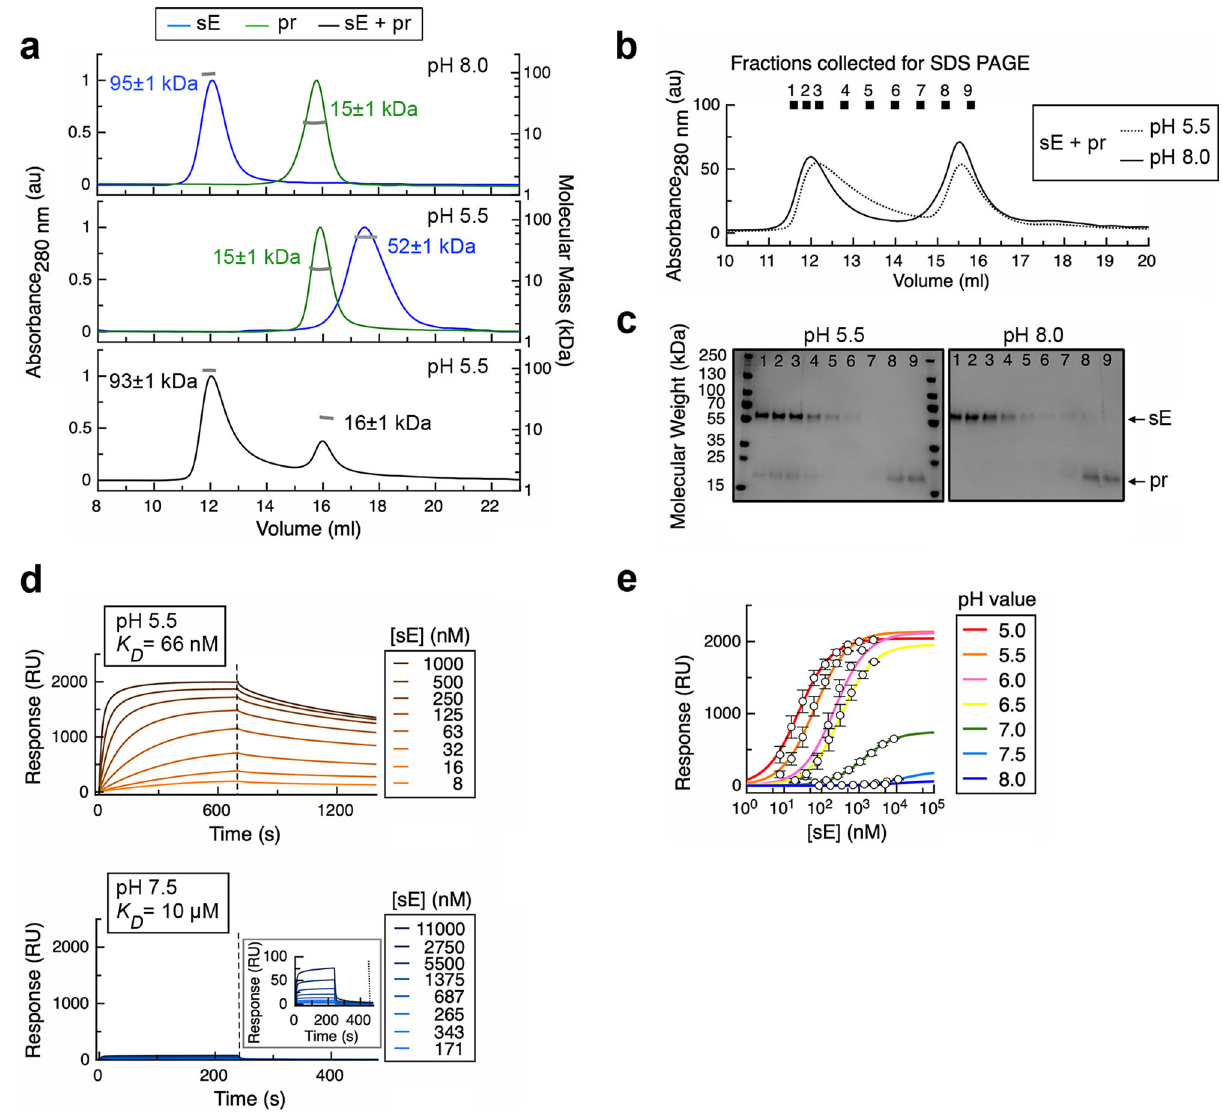
Fig. 1 pr stabilizes the sE dimer at acidic pH. a SEC elution volume pro fi les of isolated sE and isolated pr equilibrated at pH 8.0 (top panel) and at pH 5.5 (middle panel). The bottom panel shows the elution of a mixture of sE with pr in excess (1:2 sE:pr monomer:monomer molar ratio) at pH 5.5. Left y axis: the ultraviolet absorbance normalized by setting the highest peak to 1. Right y axis: molecular mass (kDa) determined by MALS, with the values for each species indicated on the corresponding peak. b Superposition of the SEC elution pro fi les of the mixture of sE with an excess pr equilibrated at pH 8.0 (smooth curve) and at pH 5.5 (dotted curve) as described in Methods. The fractions analyzed by SDS-PAGE in ( c ) are indicated (1 – 9). c SDS-PAGE of the SEC fractions indicated in ( b ) at pH 5.5 (left) and pH 8 (right); Coomassie blue staining. d Surface plasmon resonance (SPR) sensorgrams with pr immobilized on the SPR chip and sE fl owed at different concentrations (color-coded as indicated) at pH 5.5 (top panel) and pH 7.5 (bottom panel). Both panels are shown at the same vertical scale (0 – 2000 RU), with the inset in the bottom panel amplifying the range between 0 and 100 RU to show the actual curves, as the interaction at pH 7.5 is much weaker. A dashed vertical line indicates the transition from association to dissociation kinetics. e SPR association equilibrium values as a function of sE protein concentration for the titrations measured at different pH values, ranging from 5 to 8. The measurements were reproduced twice. Error bars display the mean ± SD for each individual data point. Color lines fi ts a single-site interaction model. Source data are provided as a Source Data fi which corresponding to intra-protomer and the remainder to potential of sE and pr are highly complementary at pH 5.5 but inter-protomer contacts (Fig. 2b). On pr, the surface buried by the not at 7.5, because of a speci fi c deprotonation of the E protein sE dimer is 1328 Å 2 , of which about 80% correspond to the (Fig. 2d). “ capping loop ” (CL) (labeled in Figs. 2a, 3a), so-named because it caps the E fusion loop, as described in more detail below. Map- ping the amino-acid conservation to the pr and sE surfaces pr is derived from HSP40/DnaJ chaperonins of the host . The fi rst hits of a DALI 31 search with the TBEV pr atomic model showed that both interacting regions are highly conserved across tick-borne fl aviviruses (Fig. 2c; Supplementary Fig. 2), although corresponded, as expected, to pr of other fl aviviruses, with the there is variability when comparing to mosquito-borne viruses highest Z score (15.5) for pr from yellow fever virus (Table 1). (Supplementary Fig. 3). Moreover, the surface electrostatic Lower but signi fi cant Z scores were also obtained with the